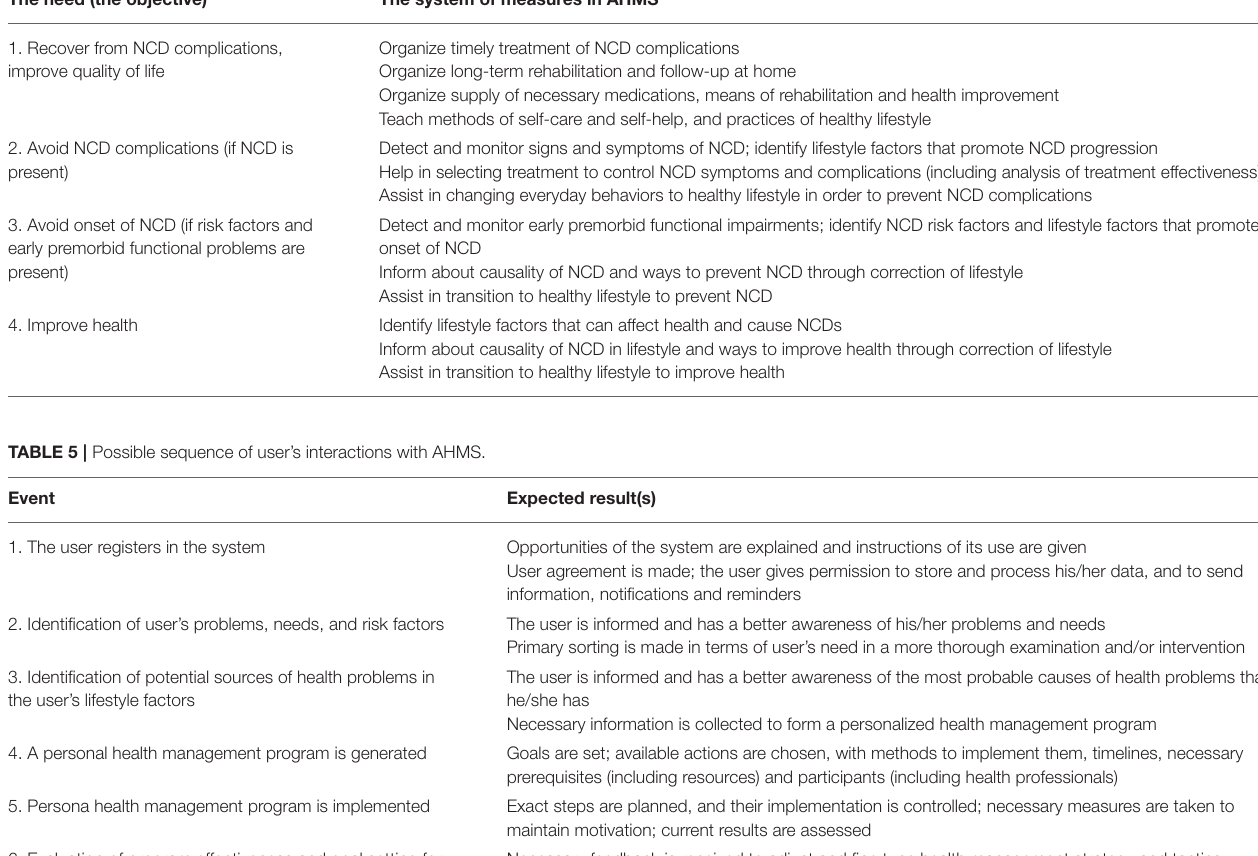
TABLE 4 | The needs of AHMS users ( = results that they want) and possible measures that can be automated in AHMS to feed those needs. The need (the objective)